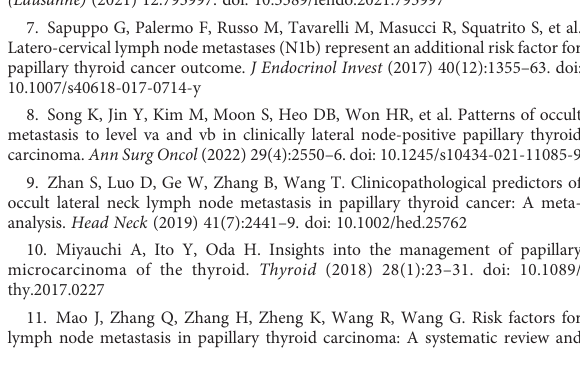
SUPPLEMENTARY FIGURE 1 Nomogram for predicting LLNM in all PTC patients. (A) preoperative nomogram; (B) postoperative nomogram. SUPPLEMENTARY FIGURE 2 ROC curves for the model. (A) AUC was 0.730 for preoperative model of predicting LLNM in all PTC patients; (B) AUC was 0.758 for postoperative model of predicting LLNM in all PTC patients. SUPPLEMENTARY FIGURE 3 Calibration curves of nomograms for predicting LLNM. (A) calibration curve for preoperative model of predicting LLNM in all PTC patients; (B) calibration curve for postoperative model of predicting LLNM in all PTC